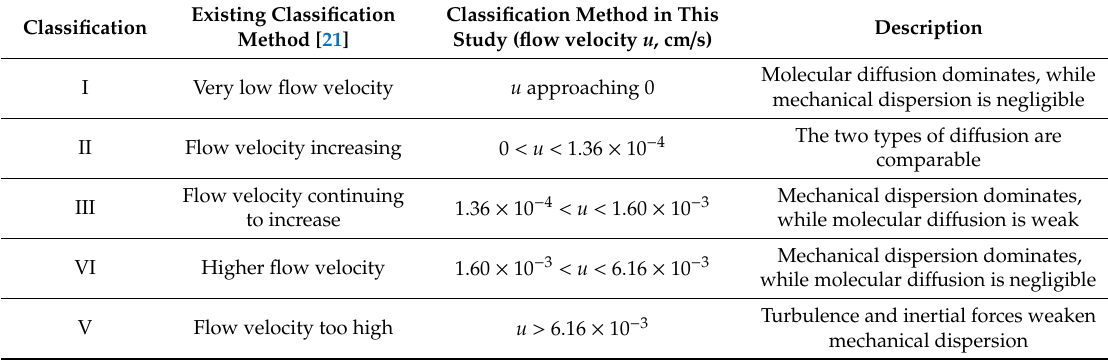
Table 3. Velocity threshold value of pore fluids that control the dispersion mechanisms.